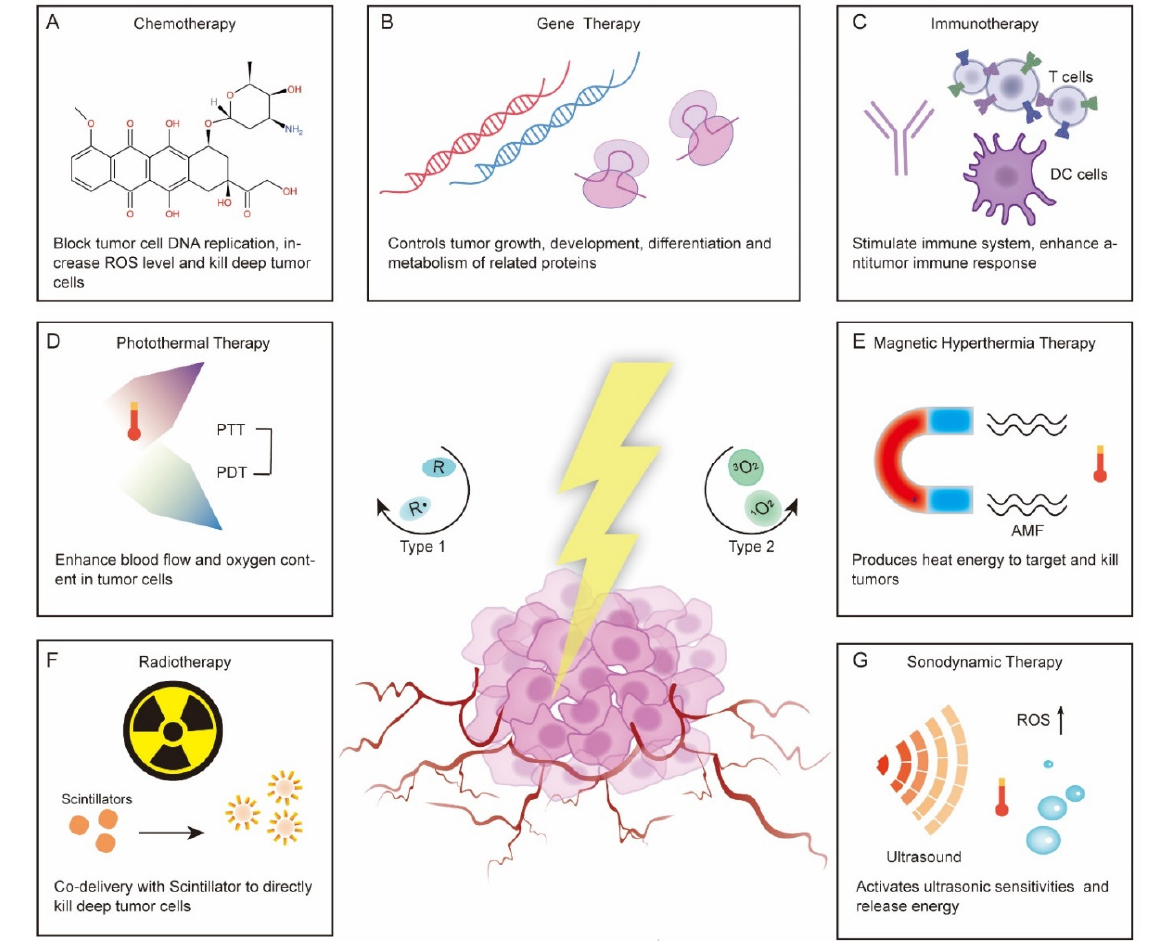
Figure 1. Combination of photodynamic therapy with various therapeutic regimens and possible synergistic antitumor mechanisms. ( A ) Chemotherapy, ( B ) Gene therapy, ( C ) Immunotherapy, ( D ) Photothermal therapy, ( E ) Hyperthemia therapy/Magnetic hyperthermia therapy, ( F ) Radiotherapy, and ( G ) Sonodynamic therapy.